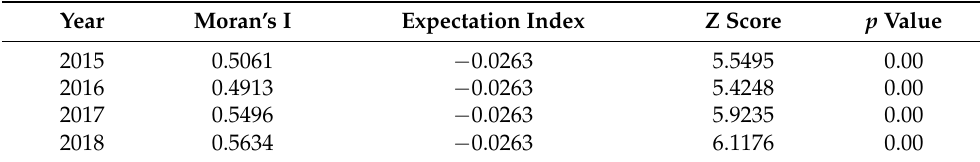
Table 3. Moran’s I of the AQI in the YRD, Table 3. Moran’ s I of the AQI in the YRD, 2015 – 2018 .